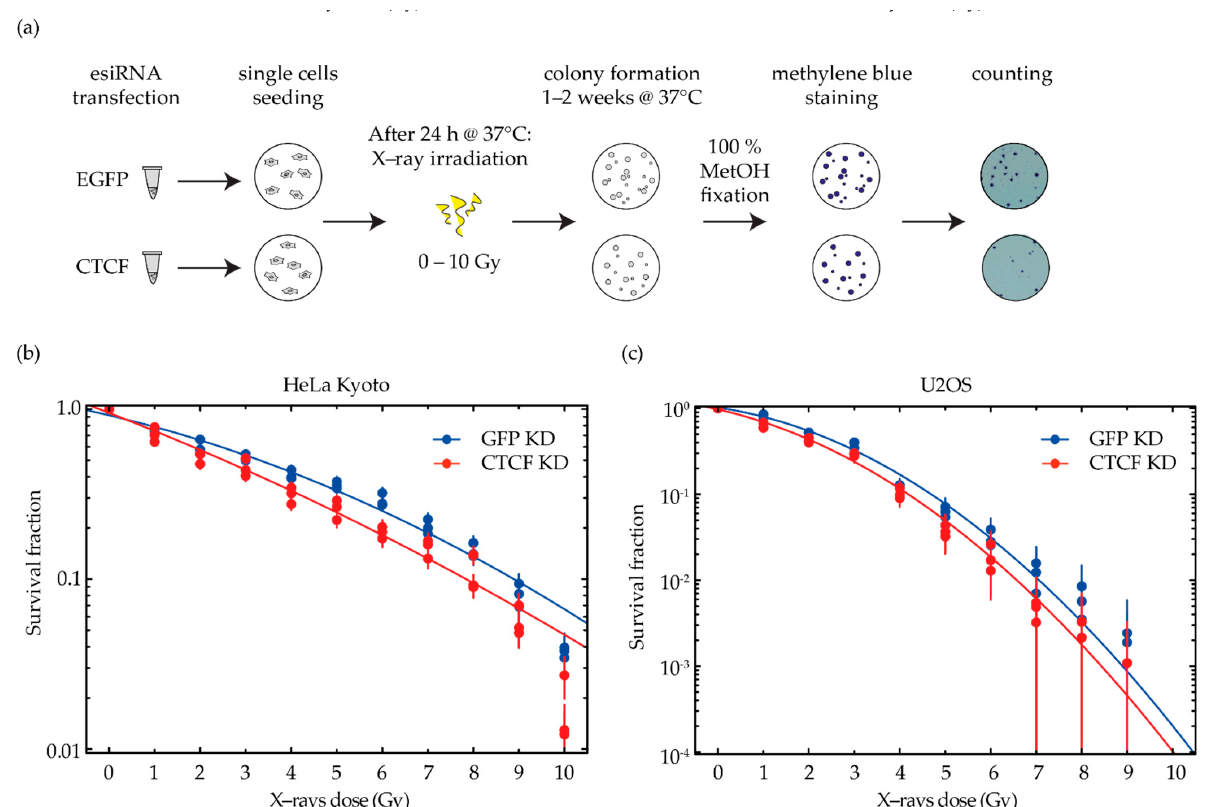
Figure 3. Radiosensitivity is increased, and relative survival is decreased upon CTCF depletion. ( a ) Experimental settings for the clonogenic assay. Cells were transfected with 15 nM of an esiRNA pool against either the human CTCF transcript or against EGFP as a mock treatment (Table S5). From each different transfection, single cells were seeded and allowed to attach before irradiation at the respective time point of maximum depletion for each cell line (40–50% of CTCF depletion at 24 h for HeLa Kyoto and U2OS, Figure 2b,c). Cells were then irradiated with different doses of X-rays and allowed to form colonies for 7–10 days under standard culture conditions. Colonies were then fixed with cold 100% methanol and stained with methylene blue. The colonies with more than 50 cells were microscopically identified and counted by eye. ( b , c ) Clonogenic assay results of CTCF-depleted HeLa Kyoto ( b ) and U2OS ( c ). The number of colonies of each technical replicate and treatment was normalized to the average of the respective unirradiated control and plotted as the relative survival fraction in a semi-logarithmic scale. A linear-quadratic dose–response curve fitting weighted by 1 was applied. The results are based on three biological replicates, each depicted as a dot relative error 2 in the survival graph and composed of technical replicates (whiskers = error bars, Table S6). Color legend: blue = GFP KD, red = CTCF KD. The same experimental data are plotted with equal y axis scaling in Figure S5a,b for a direct comparison of the 2 cell